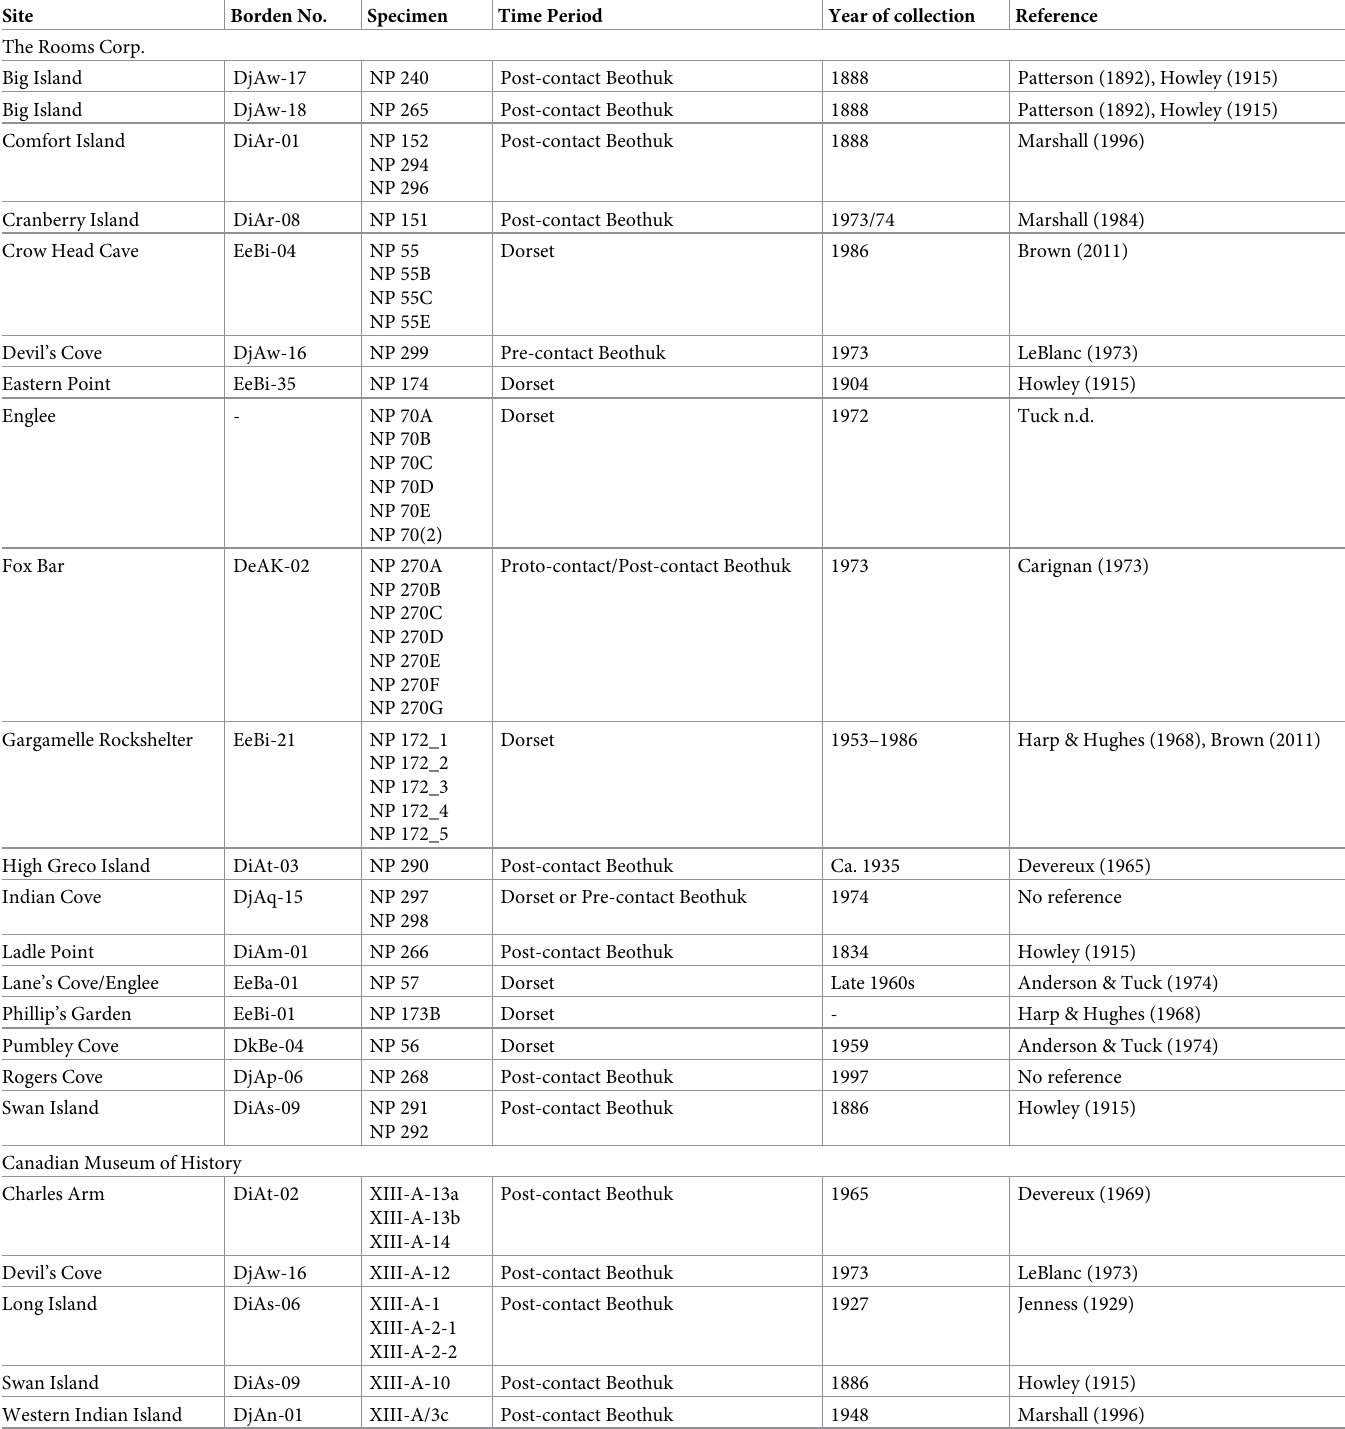
Table 1. Summary of archaeological contexts of the human skeletal remains analysed in this